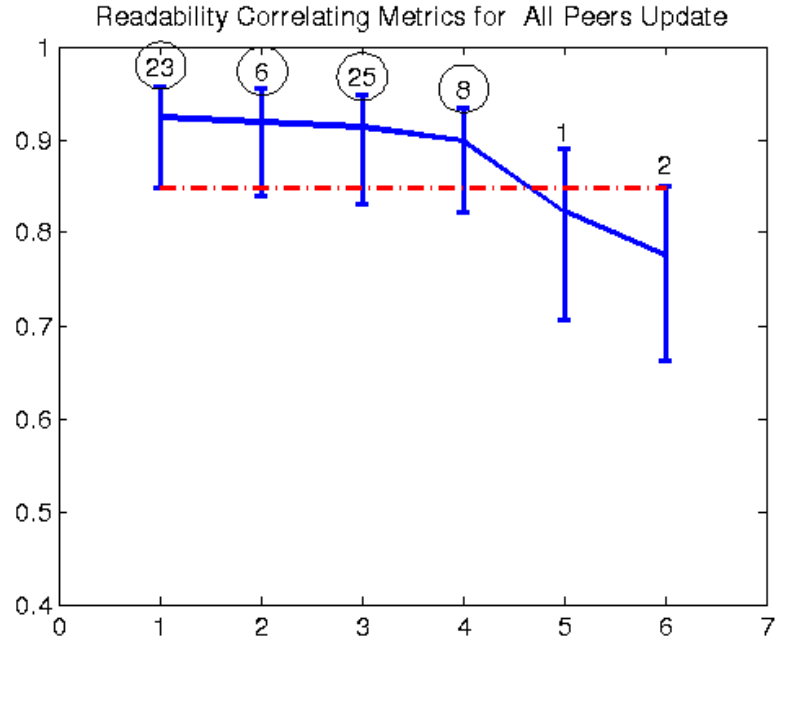
Figure 9. Pearson correlation with readability all peers and no models